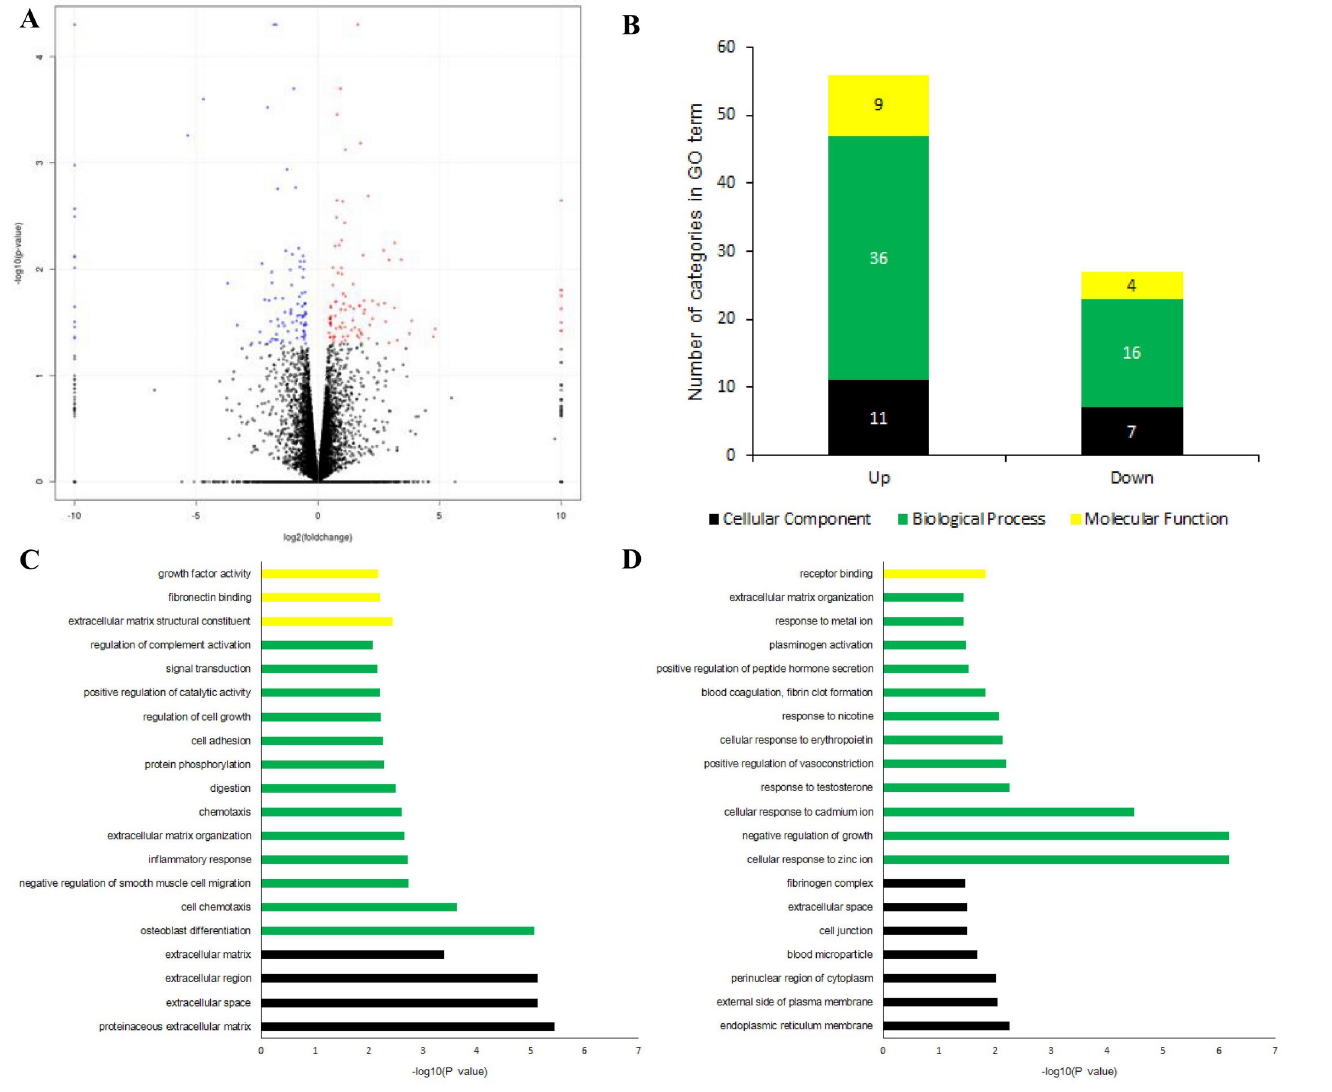
Fig 2. RNA-seq data and gene ontology analysis of TNF- α and TNF- α plus HY7714 treated Caco-2 cell. (A) Volcano plot between TNF- α and TNF- α plus HY7714 treatment. FC (fold change) > 2 was accepted as differentially expressed; red: up-regulated and blue: down-regulated. DEGs are analyzed by GO terms. The number of categories in each GO (B), and the top 20 GO terms up regulated (C) and down regulated (D). Yellow, green, and black indicate genes that belongs to the molecular function, biological process, and cellular component categories. Terms were considered significant at p <